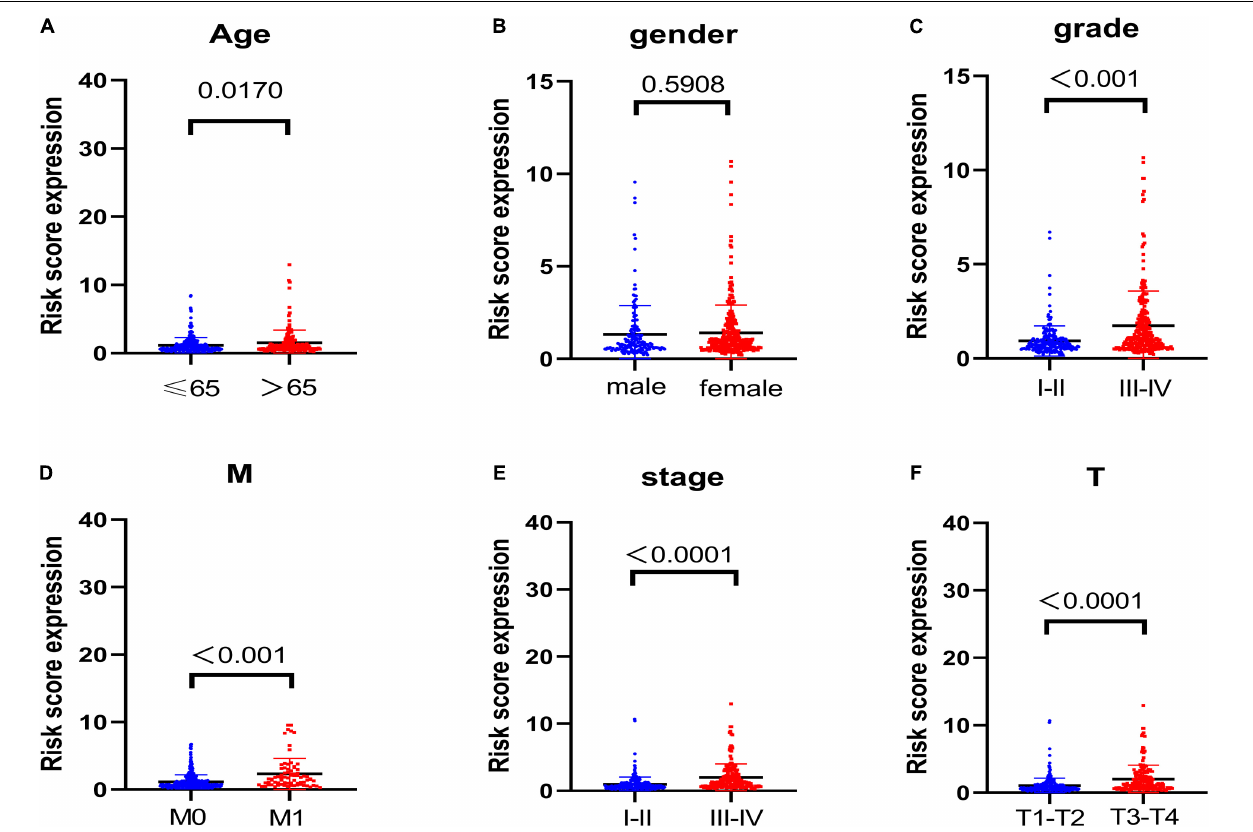
FIGURE 2 | Correlation analysis of the glycolysis-related lncRNAs prognosis signature with clinical features. The results display that except for (B) gender ( P = 0.5908), other parameters including (A) age ( P = 0.017), (C) grade ( P < 0.001), (D) M stage ( P < 0.001), (E) AJCC stage ( P < 0.0001), and (F) T stage ( P < 0.001) are significantly related to risk